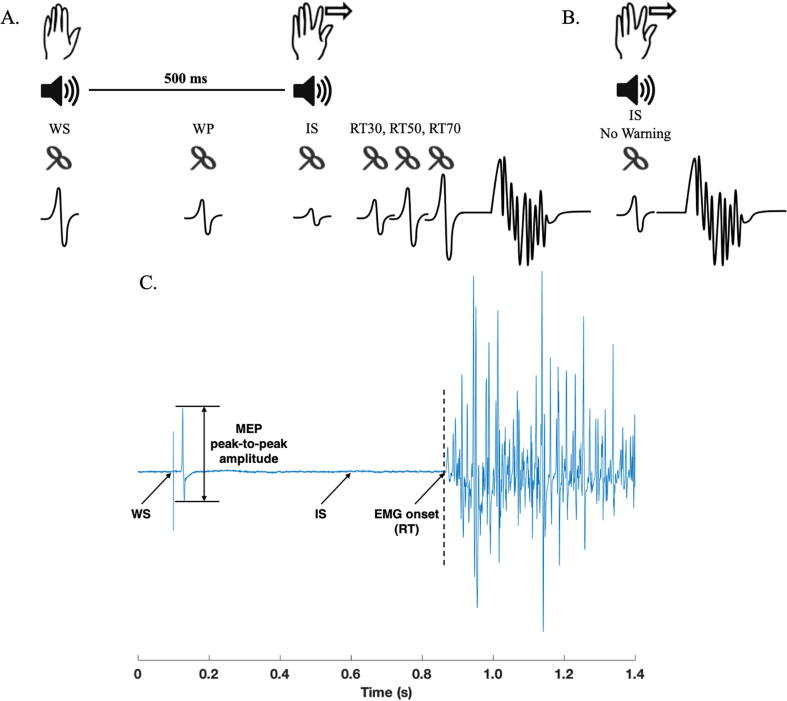
Study design for the simple auditory warned reaction time task (A) and the auditory unwarned reaction time task (B) used to study the modulation of corticospinal excitability during movement preparation. Warning Stimulus (WS), Warning Period (WP), Imperative Stimulus (IS), Imperative Stimulus (IS) No Warning, 30% RT (RT30), 50% RT (RT50) and 70% RT (RT70) indicate the different time points of stimulation across each task. Participants were instructed to carry out a ballistic index finger abduction after the auditory IS. An example electromyogram (EMG) trace indicating an motor evoked potential (MEP) and reaction time (RT) is shown in panel C.